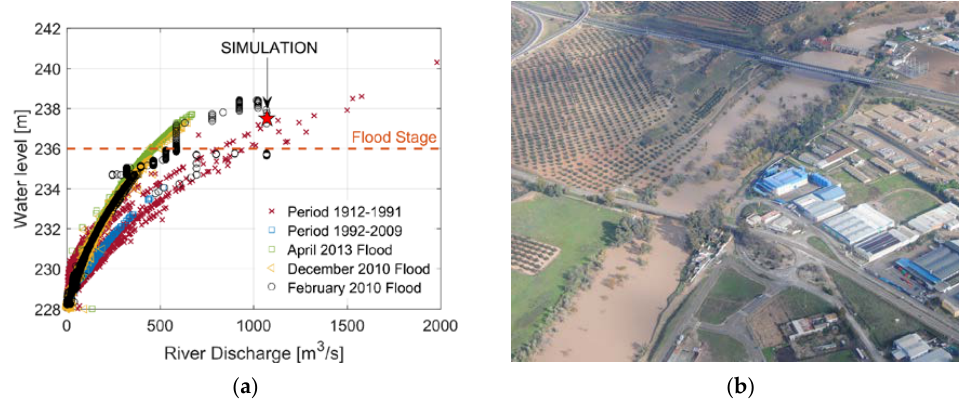
Figure 5. ( a ) Rating curves at stream gauges (650 m downstream of Mengíbar dam); and ( b ) flooded area downstream of Mengíbar dam on 8 December 2010 with the local river discharge Q = 650 m 3 ·s − 1 (flow from top to bottom). Gauge stations located on the second bridge.